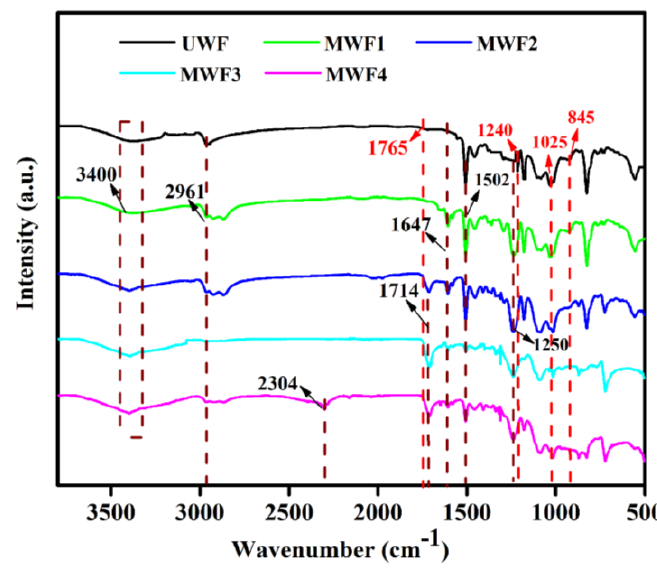
Figure 6. FTIR spectra of UWF and MWFs.